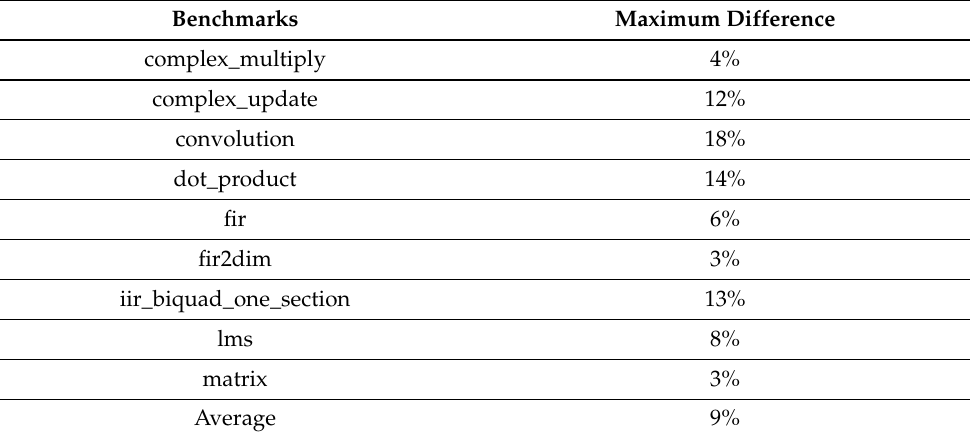
Table 2. The maximum efficiency of our packing-oriented approach as compared to the sequen- tial